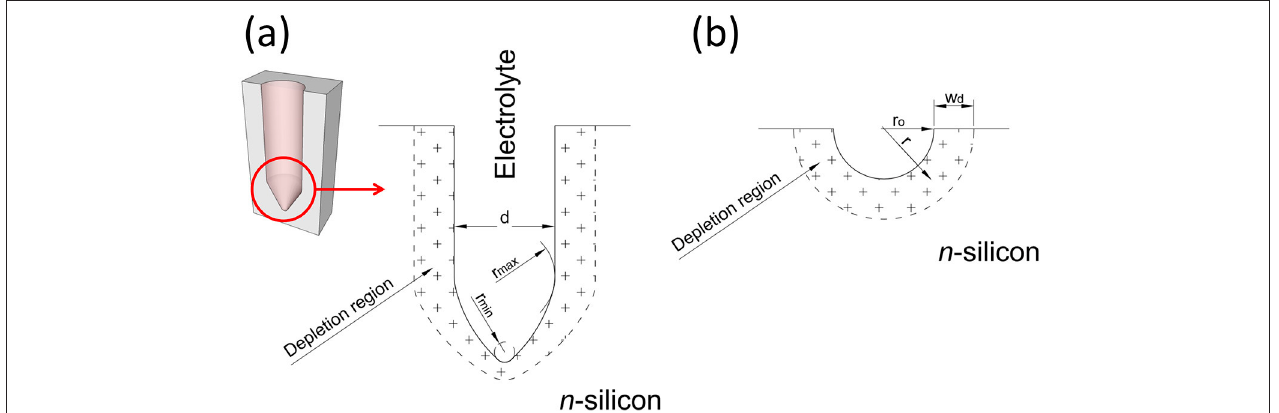
FIGURE 2 | Sketch of the electrolyte/silicon interface of a pore, with depletion region establishing into the silicon substrate highlighted. (a) Pore-shaped electrolyte/silicon interface; (b) hemispherical-shaped electrolyte-silicon interface. The radius of curvature of the electrolyte/silicon interface at the pore tip raises monotonically from the tip apex, minimum value r min , to the pore radius, maximum value r max = d /2, assuming for the pore a circular cross-section with a diameter d .